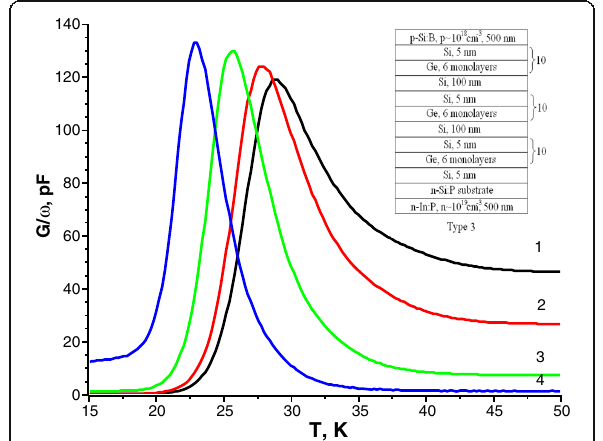
Fig. 3 Temperature spectra of conductance for sample type 3 measured at the applied bias voltage of – 0.5 V and various frequencies of the test signal 1 1000 kHz, 2 500 kHz, 3 100 kHz, and 4 10 kHz. The inset shows the structure of samples